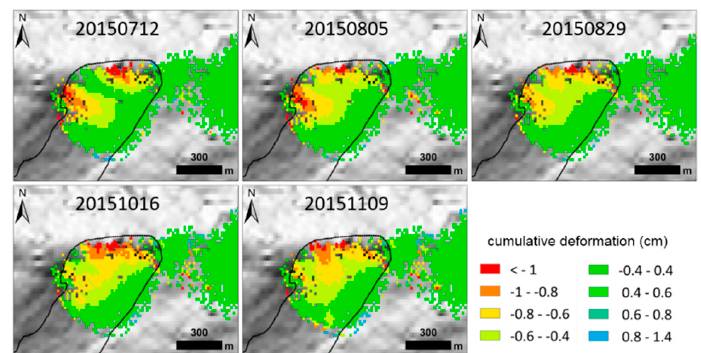
Figure 9. The time series deformation from Sentinel-1 data in the LOS direction. The reference time for cumulative deformation begins 9 October 2014. The entire time series deformation is shown in Figure S1.